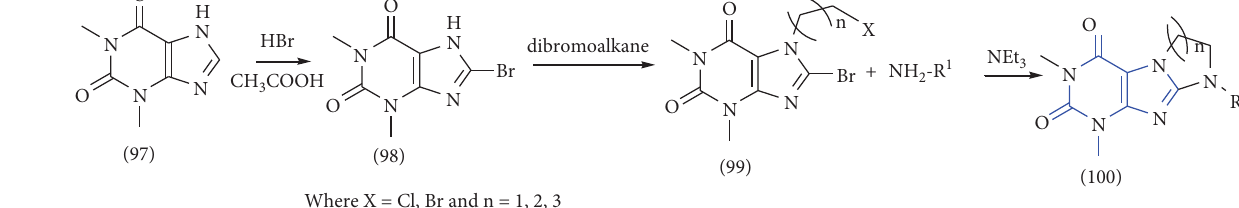
Scheme 16: Synthesis of tricyclic xanthine derivatives.